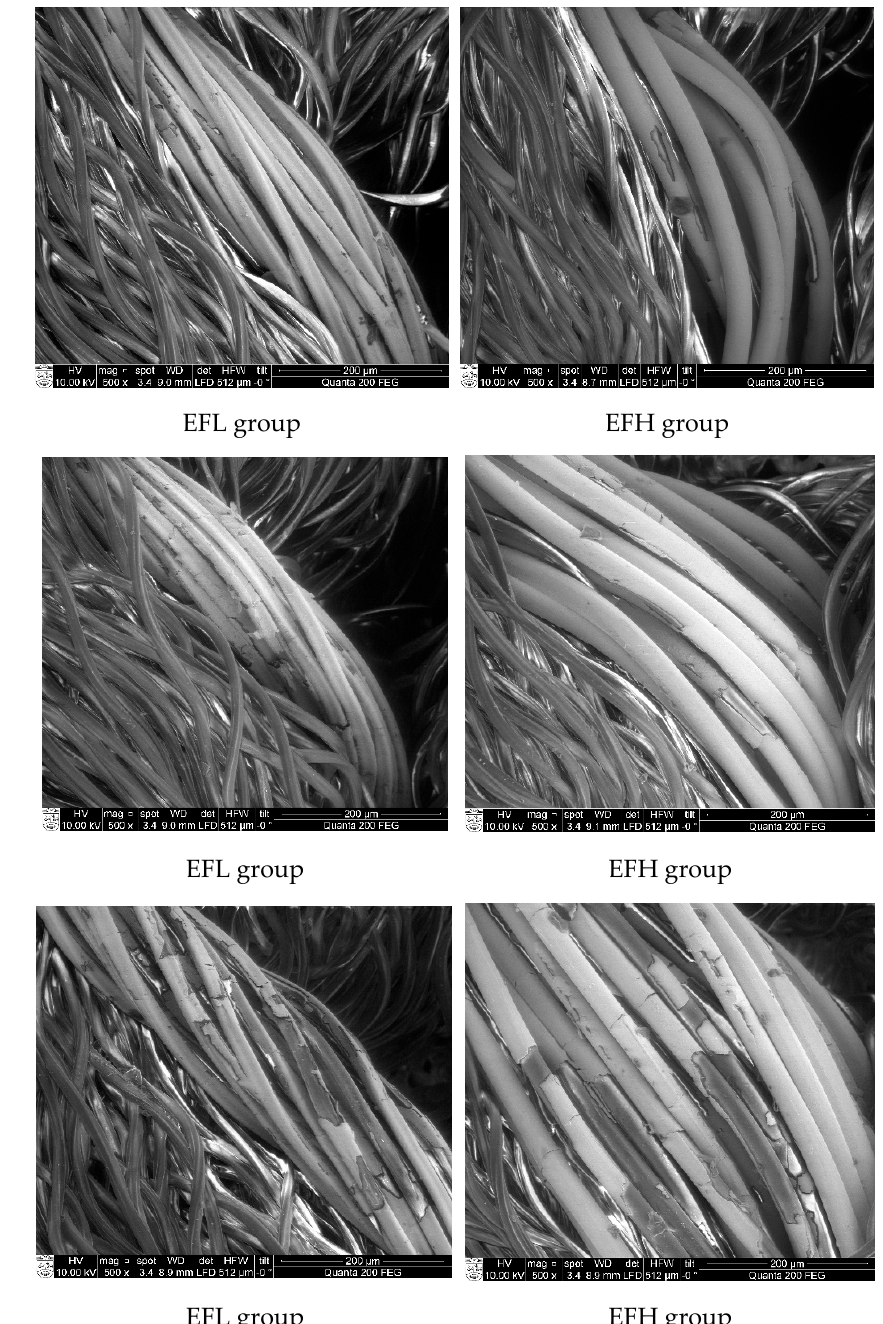
Figure 10. SEM images of electro-conductive yarns in EFL and EFH group fabrics after 1st, 3rd, and 5th washing cycles (500× magnification) .